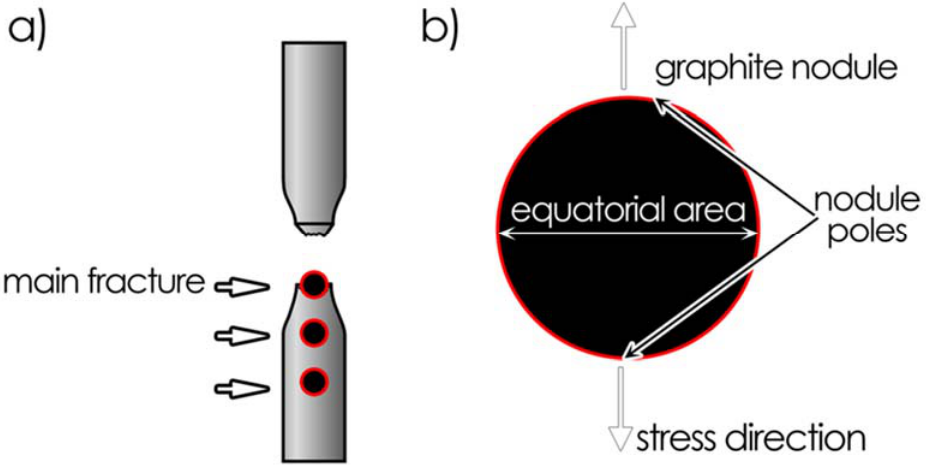
Figure 2. Arrangement of the observed microregions; ( a ) on the examined cross-section of specimen, ( b ) in graphite nodule.